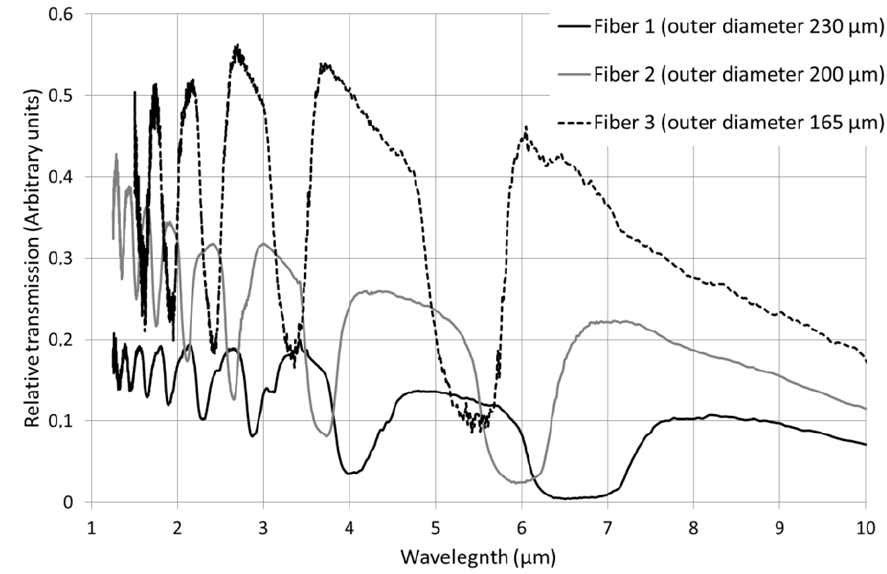
Figure 4. Infrared transmission bands of the Fibers 1, 2 and